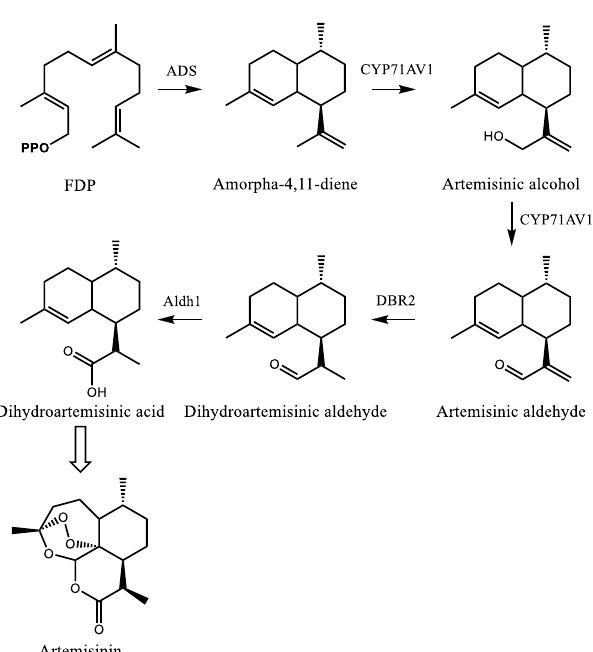
Figure 6. Steps in the biosynthesis of the sesquiterpene lactone artemisinin in A. annua . Enzyme abbreviations are as follows: ADS – amorpha-4,11-diene, CYP71AV1 – cytochrome P450 71AV1, DBR2 – double bond reductase 2, Aldh1 – aldehyde dehydrogenase 1. OPP signifies a diphosphate moiety and FDP represents farnesyl diphosphate. The open arrow indicates photooxidative steps involved in the formation of the endoperoxide ring which remain uncharacterized.